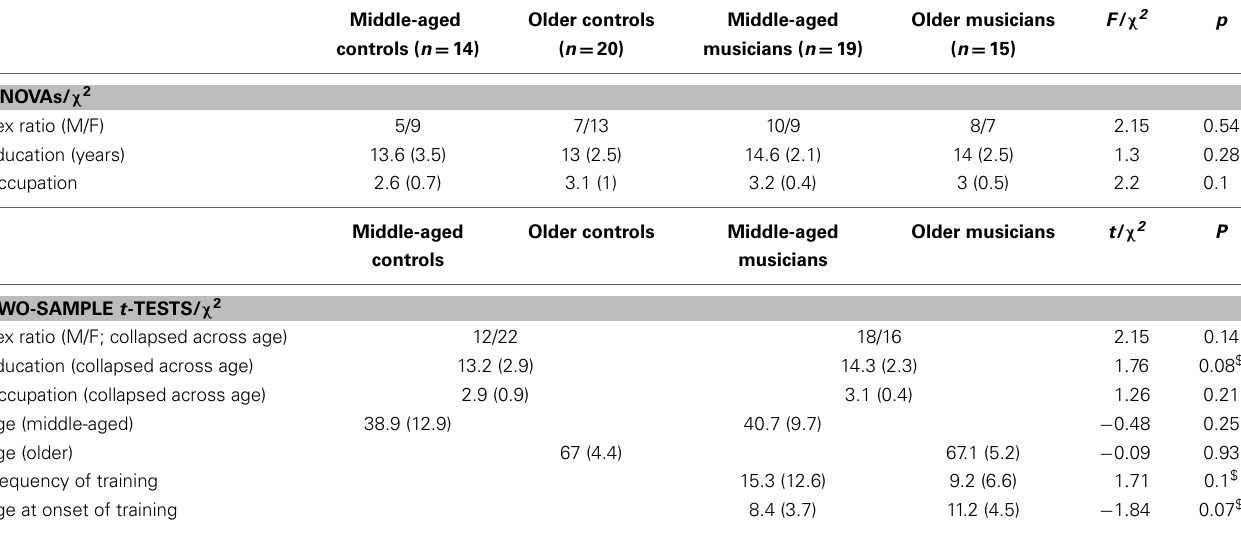
Table 1 | Means (SDs) and inferential statistics for demographic data and characteristics of musical practice (trend/significance p -values: $ p ≤ 0 .